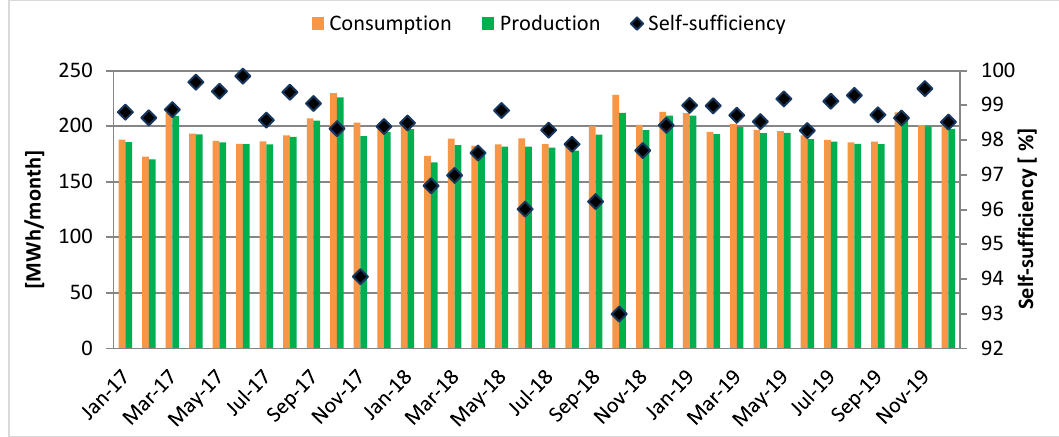
Figure 13. Energy balance at the Iława WWTP .